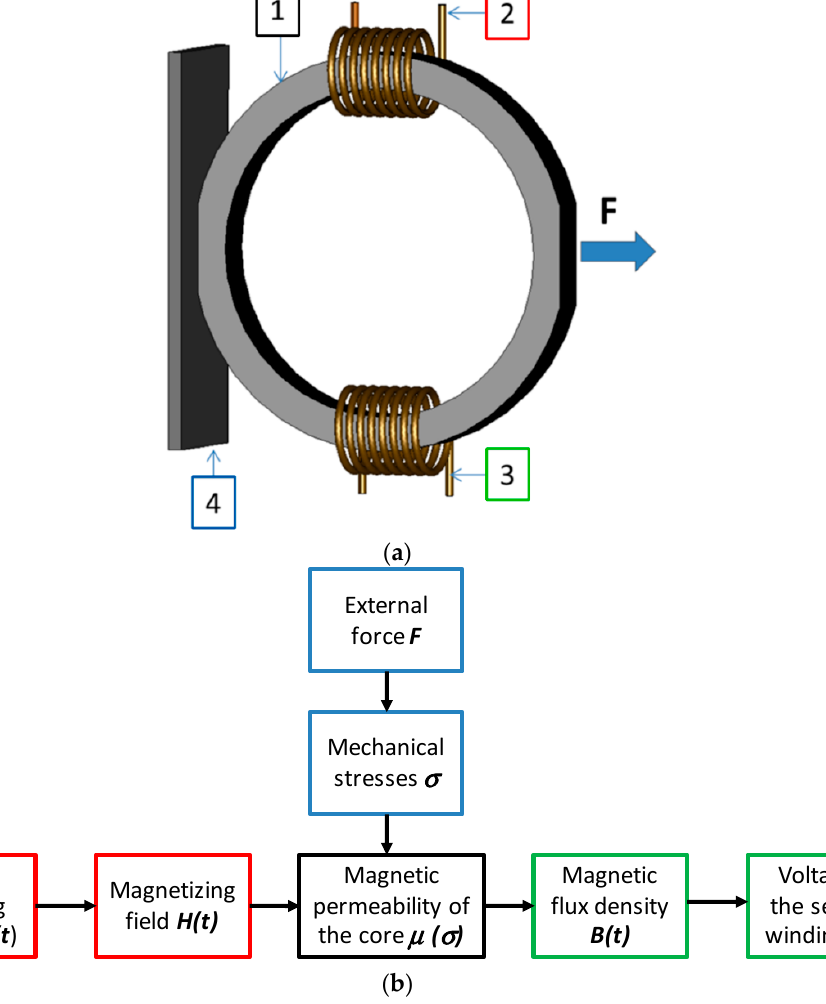
Figure 1. Magnetoelastic sensor in Mohri’s configuration: ( a ) general view of a ring-shaped sensor [8]: 1–a magnetoelastic core, 2–a driving winding, 3–a sensing winding, 4–a base plane; ( b ) schematic diagram explaining the principles of operation of the sensor.